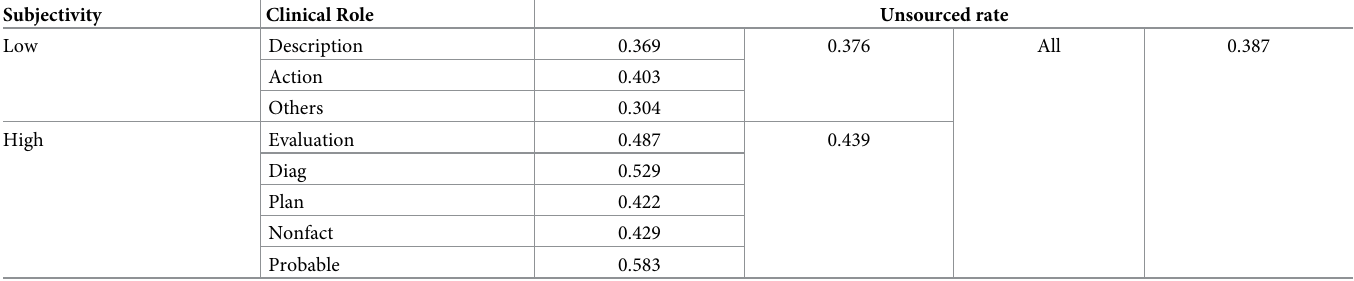
Table 5. Rate of unsourced segments in detailed labels. Because the clinical role and the subjectivity labels are automatically added as different tasks, the subjectivity label is not a weighted average of the clinical role labels. In contrast, “All” is a weighted average of low and high subjectivity.